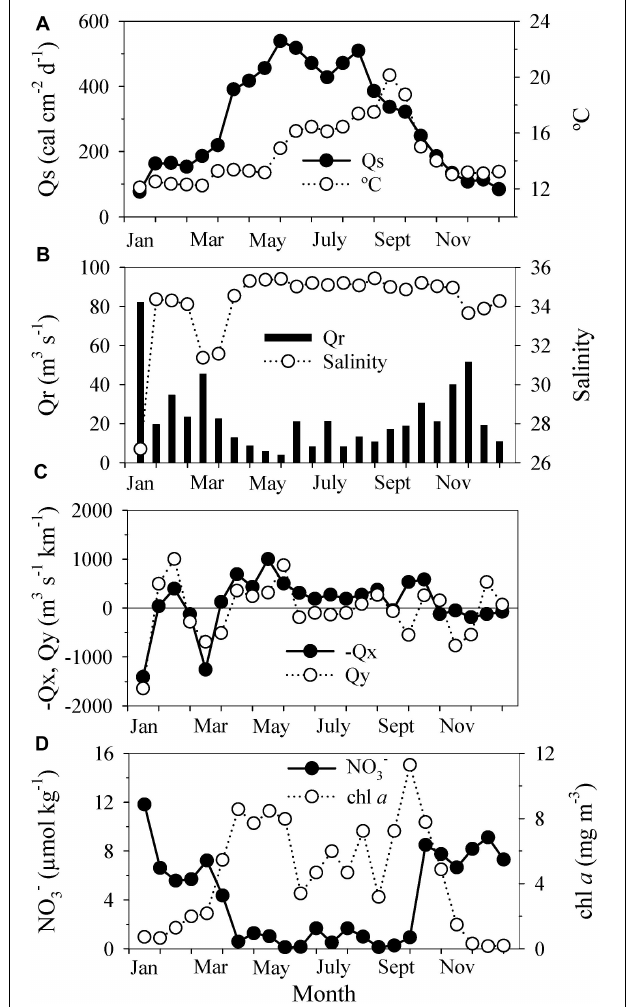
FIGURE 2 | Time series of (A) incoming solar radiation (Qs) and seawater temperature ( ◦ C), (B) runoff (Qr) and surface salinity, (C) cross-shelf (–Qx) and alongshore (Qy) Ekman transport, and (D) nitrate (NO − 3 ) and chlorophyll a (chl a ) concentrations in the surface layer. The values were averaged every half-month ( n = 3–5) to remove short-term